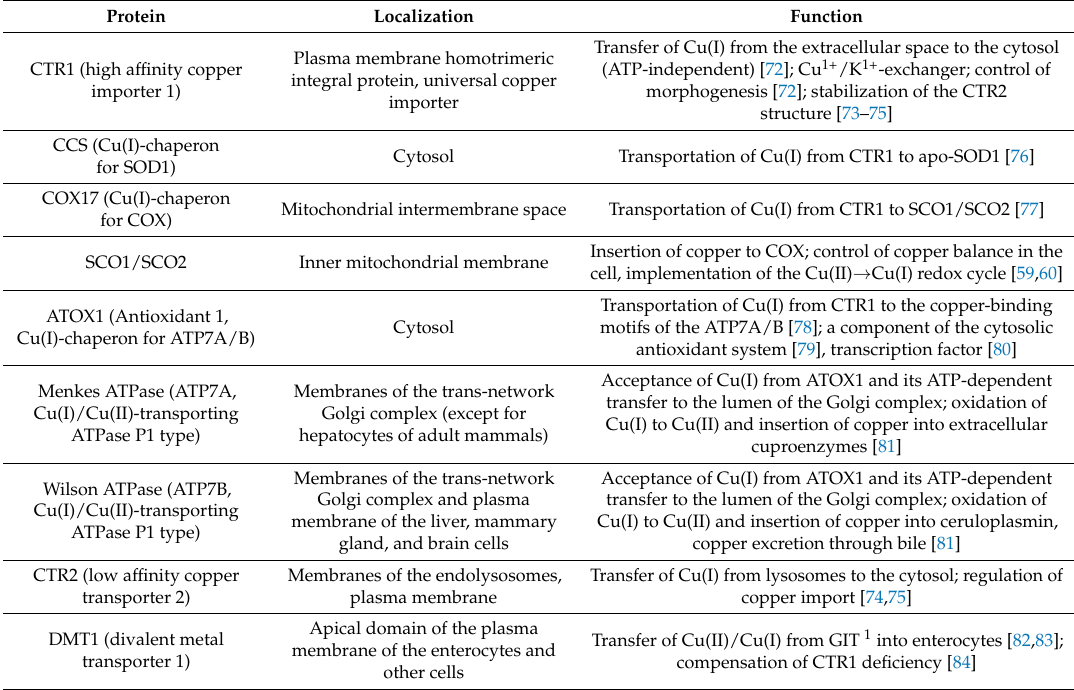
Table 3. Mammalian copper transporting proteins involved in intracellular copper